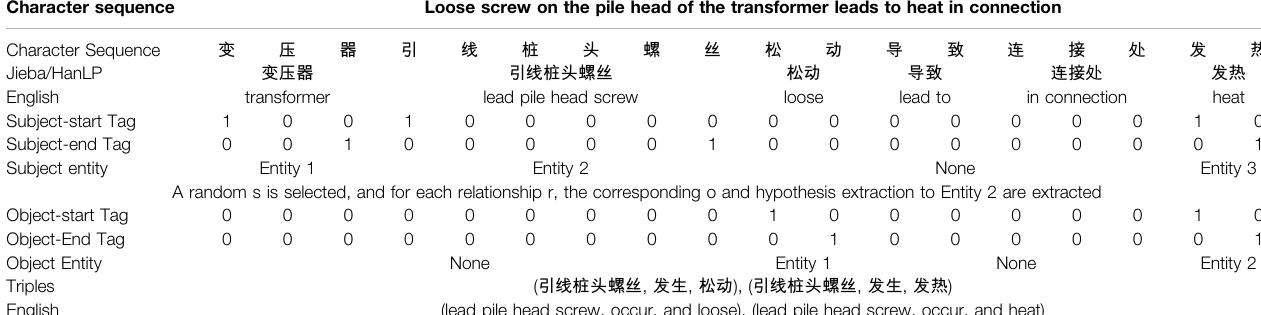
TABLE 6 | Triple extraction of the power transformer.